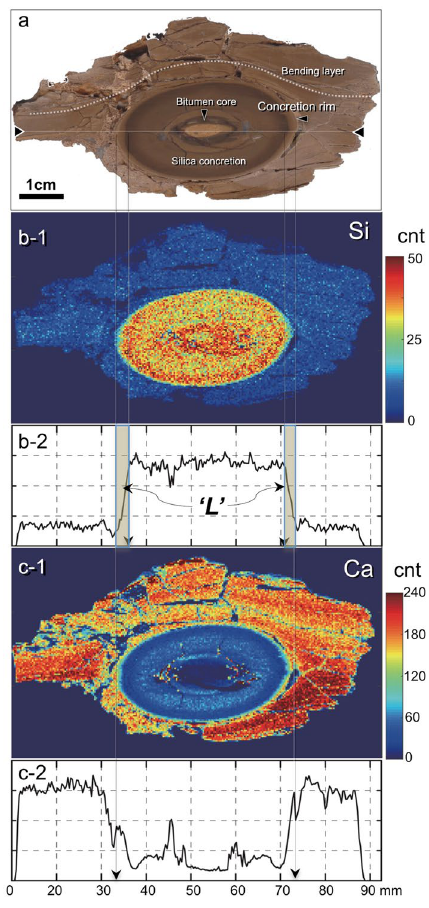
Figure 2. Si and Ca distributions in and around a silica concretion. ( a ) View of a plane cut through the centre of a silica concretion and the surrounding sedimentary rock. ( b,c ) Si ( b-1,2 ) and Ca ( c-1,2 ) distribution maps and concentration profiles (dotted line) across a silica concretion measured by SXAM (cnt: X-ray intensity; count per second). ‘L’ shown in the Si profile ( b-2 ) is the width of the reaction front developed during concretion formation. Photograph ( a ) shown here is taken by H.